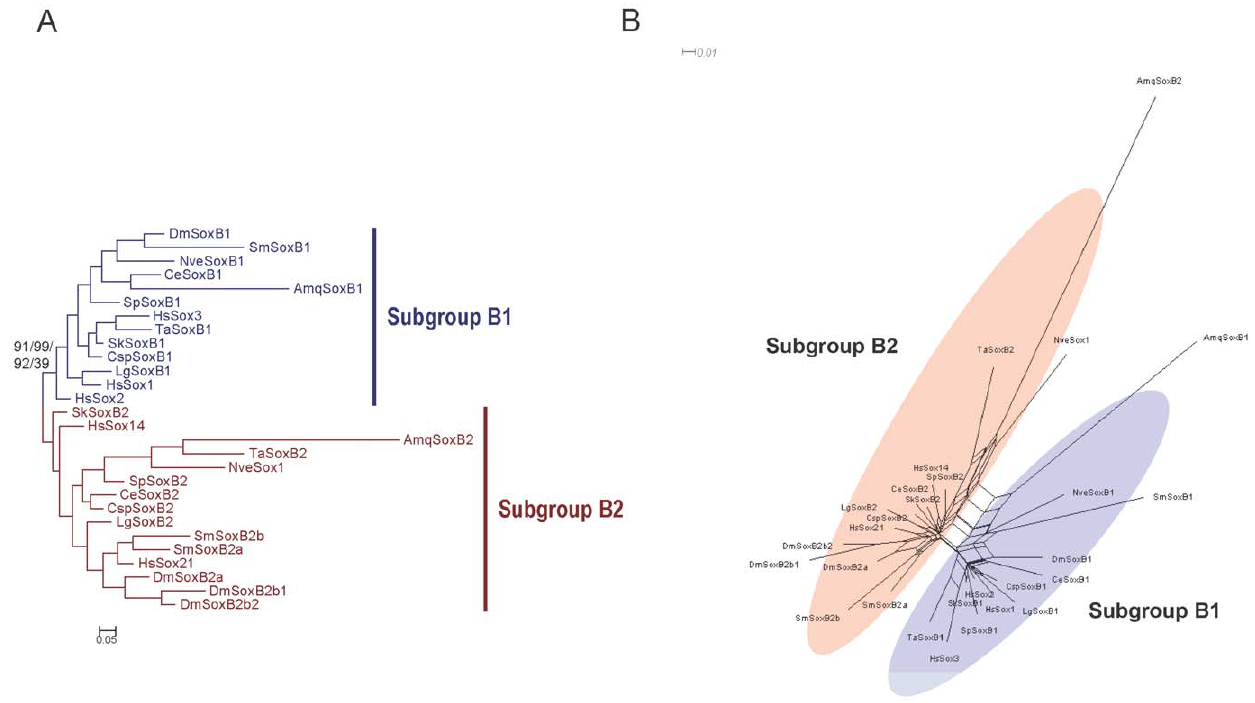
Figure 3. Phylogenetic tree and split network of the representative metazoan SoxB1/B2 proteins based on the HMG domain alignment. (A) Bayesian tree is shown. Statistical support values for the SoxB1/SoxB2 split were derived by different methods: the first number is based on posterior probabilities in the Bayesian analysis; the second number is the support calculated with the approximate likelihood ratio test in the ML analysis; the third number is the support calculated with an SH-like test in the ML analysis; and the fourth number is the support calculated with 100 bootstrap replicates in the ML analysis. The model for the Bayesian reconstruction was RtREV + I (invariable sites) + G; the model for the ML reconstruction was LG + I + G. (B) Split network under the JTT model is shown. Abbreviations of species names are as in Table 1.